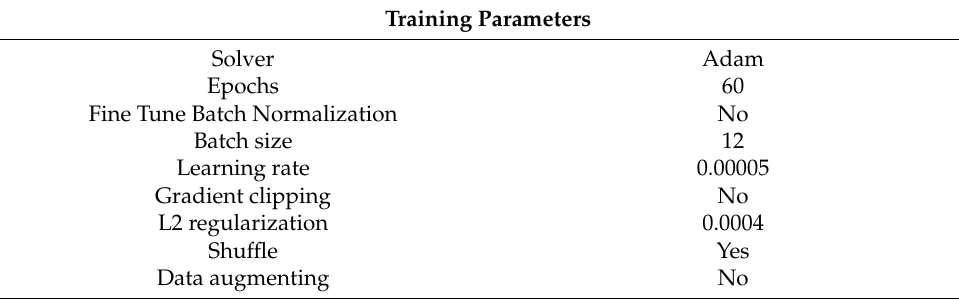
Table 7. Training parameters for DeepLabV3+ on